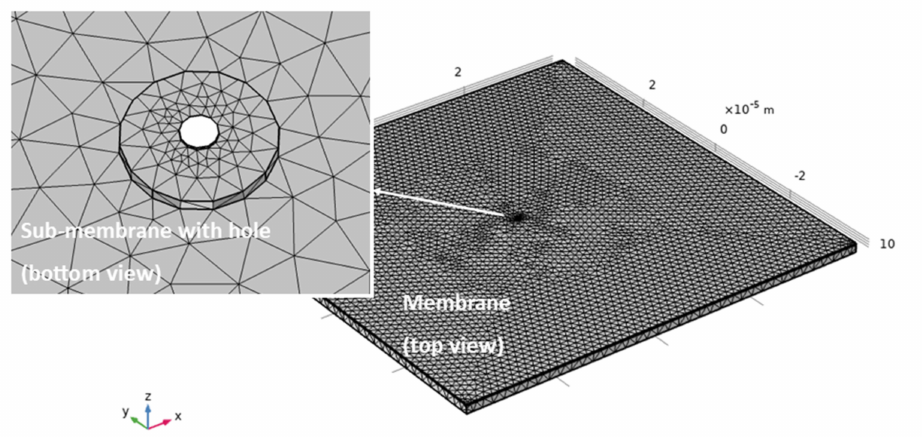
Figure 3. Model mesh of a 50 µ m side membrane with a thickness of 1.7 µ m, having a sub-membrane at its center, with radius of 2 µ m and thickness of 200 nm, and an orifice diameter of 500